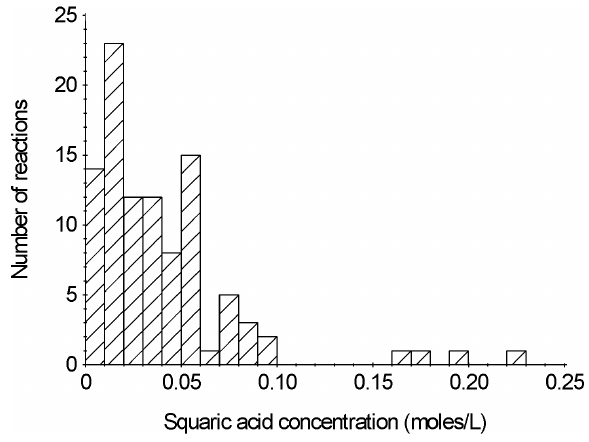
Figure 1. Bar graph showing the number of reactions undertaken covering each range of concentration of squaric acid used (+0.01 moles/L); calculated from total solvent